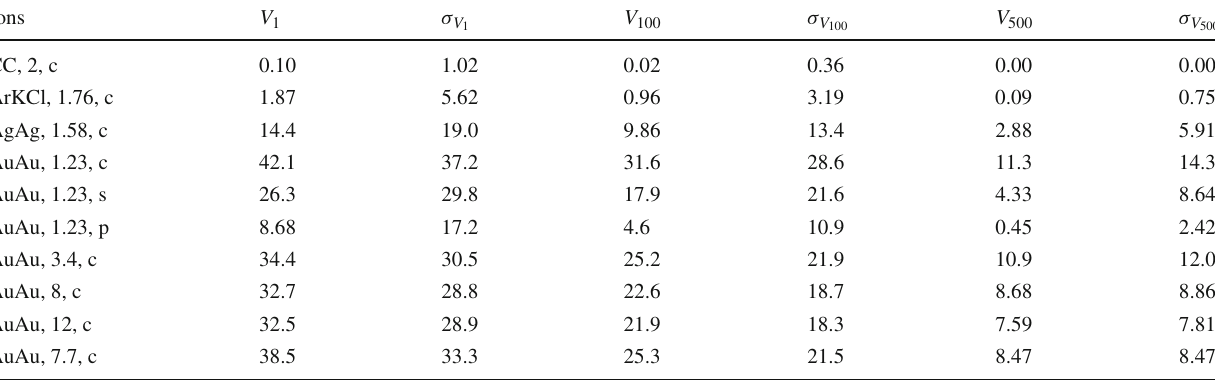
Table 6 Results for X ebe < 0 . 1 and Y ebe < 0 .